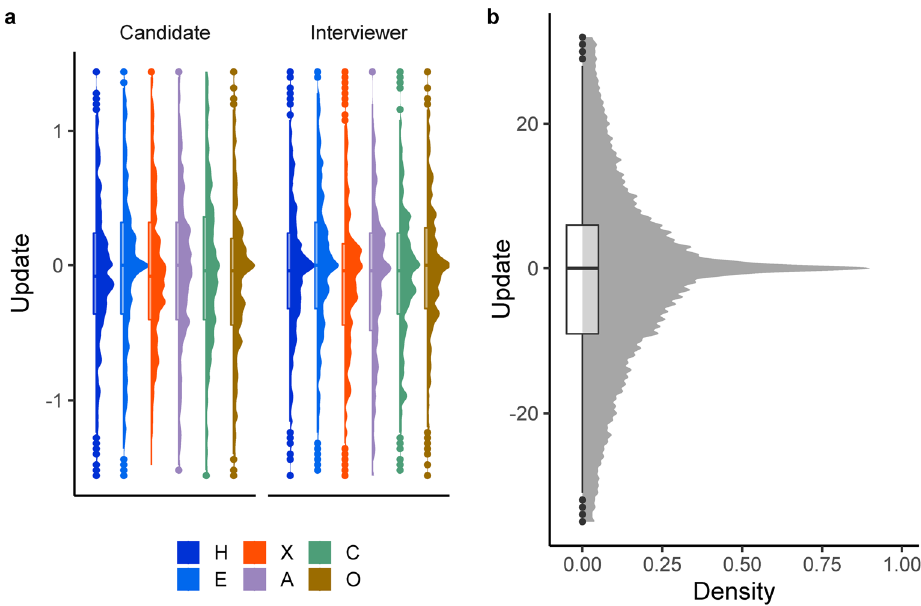
Figure 1. Density plots and boxplots of the distributions of updates in trait estimates and mental state inferences for the Interview Task. An update was calculated as the difference in an estimate between two consecutive judgements (i.e., from before the video to the mid-point, and from the mid-point to the end). An update of zero indicates no change, whilst non-zero datapoints indicate an update to the given rating in the given direction (i.e., positive = increase, negative = decrease). (Panel a ) The distribution of updates for each trait for each Target ‘type’ (i.e., Interviewer or Candidate). H = honesty-humility, E = emotionality, X = extraversion, A = agreeableness, C = conscientiousness, O = openness to experience. (Panel b ) The distribution of mental state